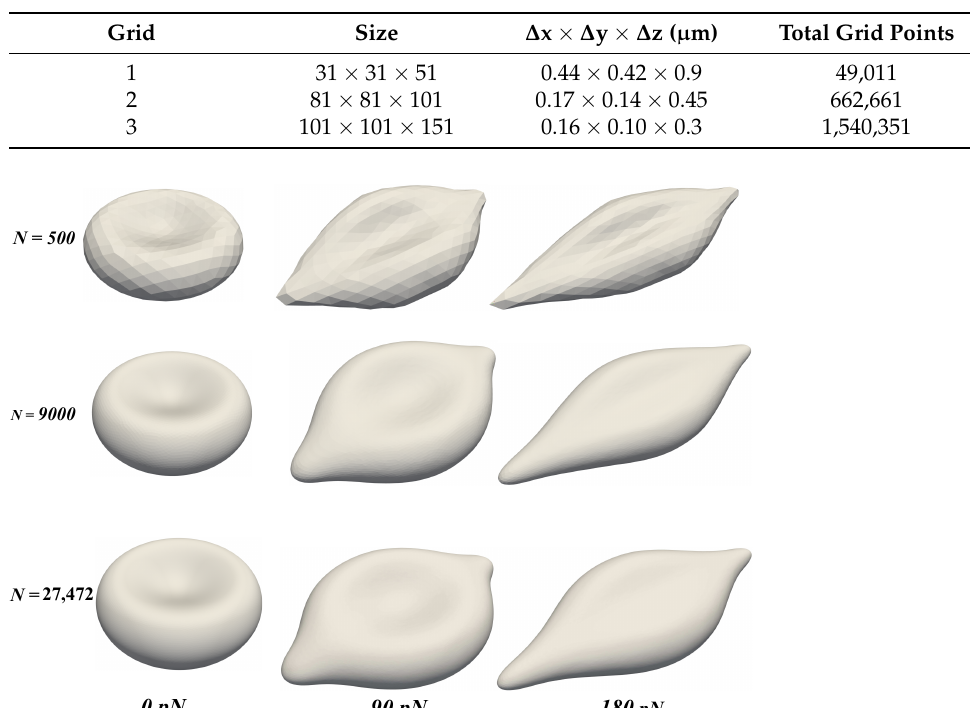
Table 2. Grid refinement study for the Fluid-Structure Interaction (FSI) simulation of a single RBC in uniform flow. The RBC is simulated with the coarsest DPD model ( N v = 500) as seen in Table 1. The domain ( − 5:5, − 5:5, − 22.5:22.5) µ m is discretized as a structured grid with uniform spacing in ( x , y , z ) directions as shown in Figure 6.